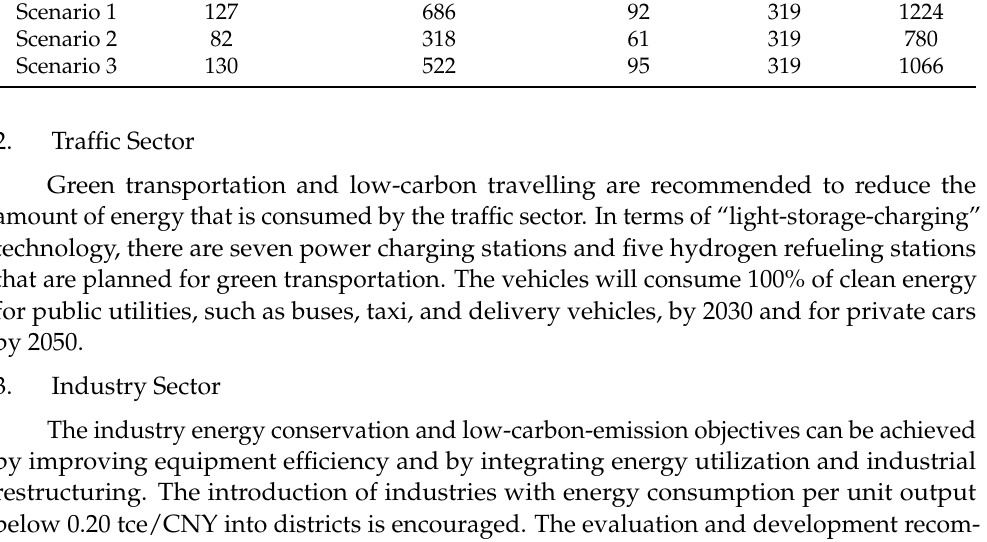
Table 10. PV layout plans for different types of buildings by 2030 (40 MW in existence). Building Type